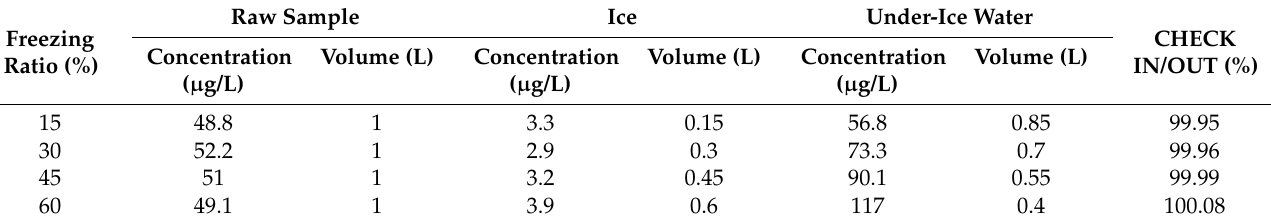
Table A1. Mass conservation verification of the freezing ratio.